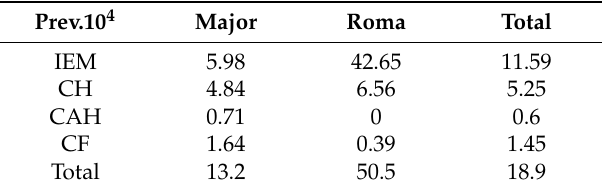
Abb.: OR—Odd ratio. Table 3. Total and ethnic prevalence of screening disorders (n to 10 4 ).